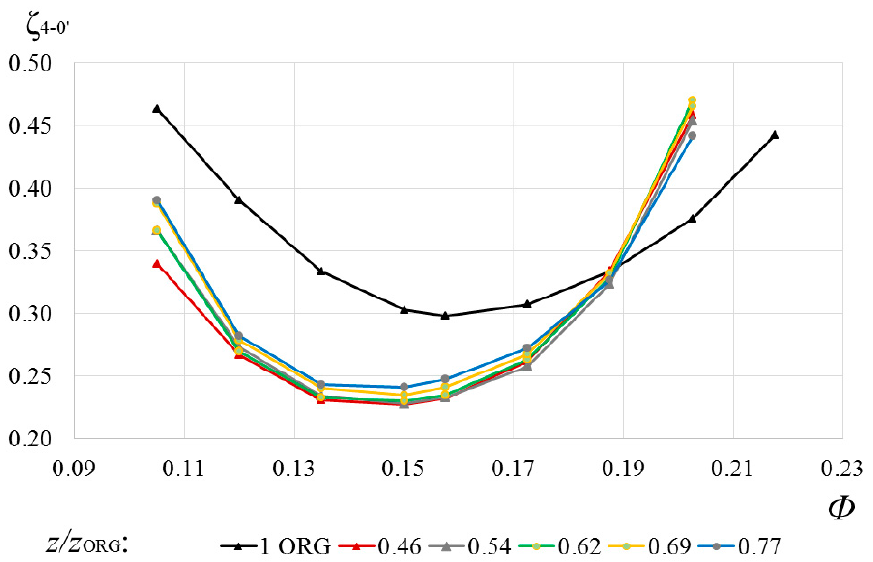
Figure 24. Loss coefficient characteristics of the RCh variants with different numbers of vanes at the Figure 24. Loss coe ffi cient characteristics of the RCh variants with di ff erent numbers of vanes at the b b = and the characteristics of the variants according to the preliminary design. optimal height 5 6 optimal height b 5 = b 6 and the characteristics of the variants according to the preliminary